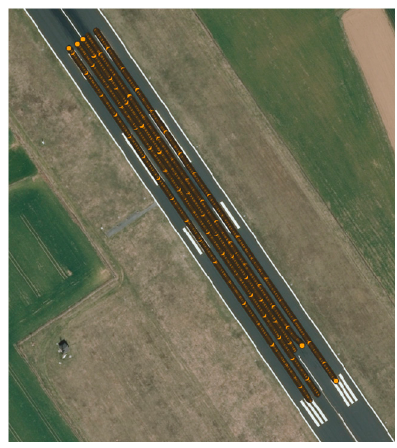
Figure 2 . Measured data set. Figure 2. Measured data set.